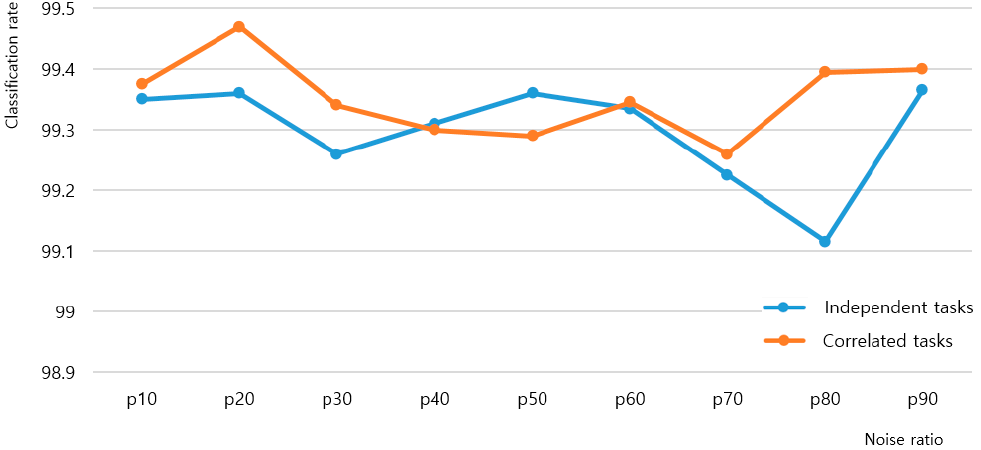
Figure 8. Classification rate (%) for digit recognition.